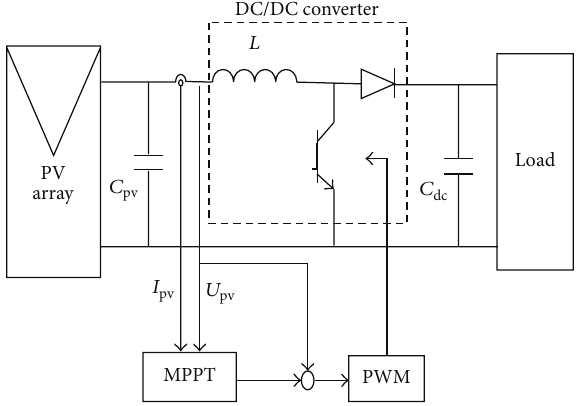
Figure 12: MPPT main